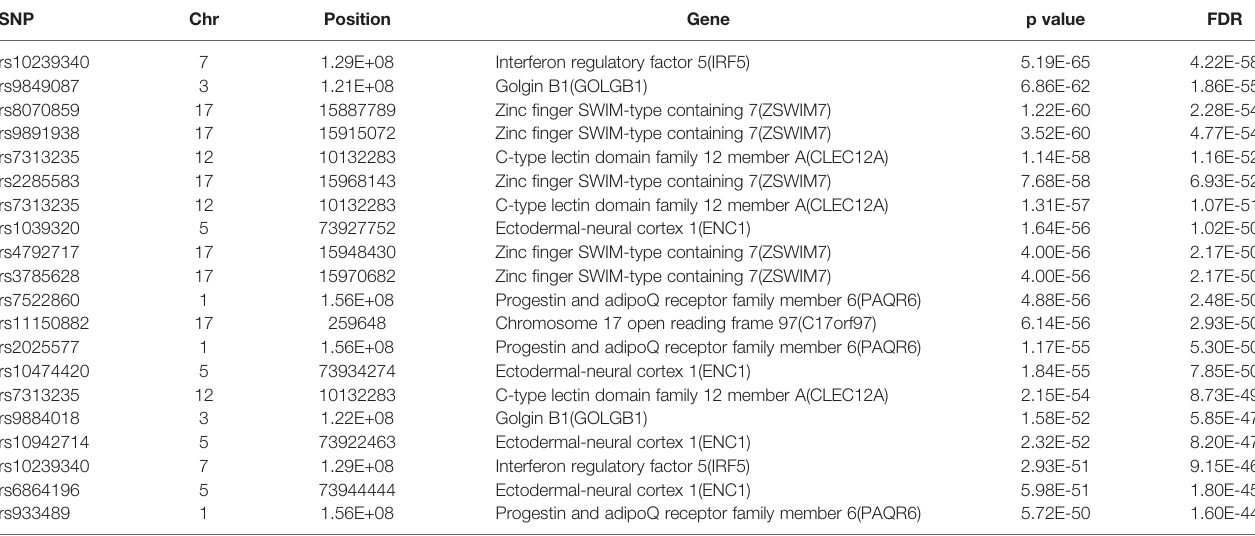
TABLE 1 | The top 20 most signi fi cant m 6 A-cis-eQTLs in sepsis.